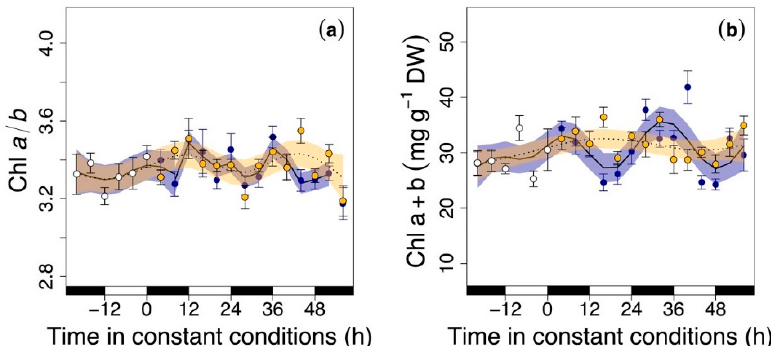
Figure 2. Chlorophylls in rocket leaves during the last cycle of the entrainment phase (white circles) and under continuous darkness (blue circles) and light (yellow circles): ( a ) the chlorophyll a to b ratio (Chl a / b) and ( b ) total chlorophylls expressed on dry weight (Chl a + b; mg g − 1 DW). Black and white rectangles on the x -axis represent subjective night and day, respectively (that is, when leaves would have experienced nighttime or daytime conditions). Time zero represents the time when constant conditions started. Temporal patterns were examined with the generalized additive model (GAM) fitted with an automated smoothness selection [31]. Shaded areas indicate the 95% confidence interval (CI) of the fitted GAM. Values are the mean of 10 replicates ± standard error (S.E.)